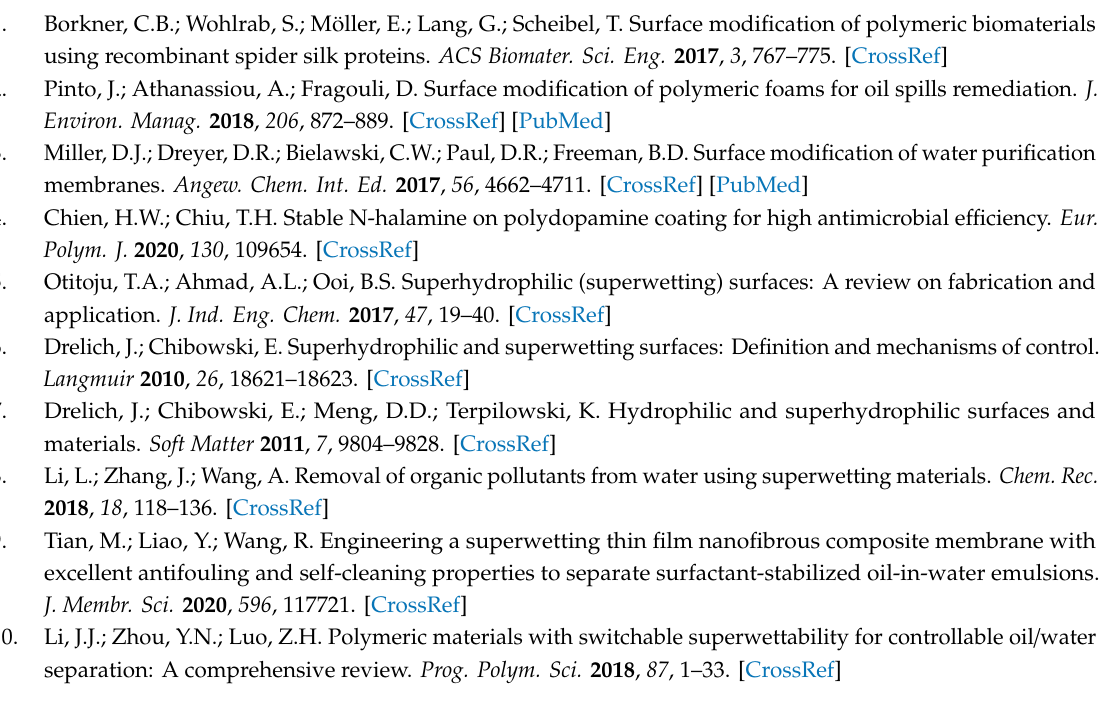
Figure S1: Particle size of PDA / SBMA solution at 2 h with NaIO 4 trigger, Figure S2: UV-VIS spectral change for PDA / SBMA (1:25) solution without (A) and with NaIO 4 (B) trigger against the reaction time. The graph of OD 410 values with respect to the polymerization time. Figure S3: Soybean oil were used for oil / water